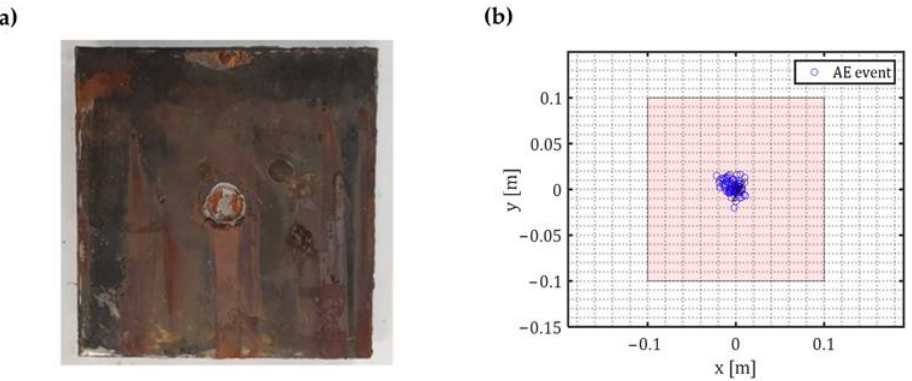
Figure 16. ( a ) Corrosion damage on the marine growth covered plate; ( b ) Localisation results on the marine growth covered plate.